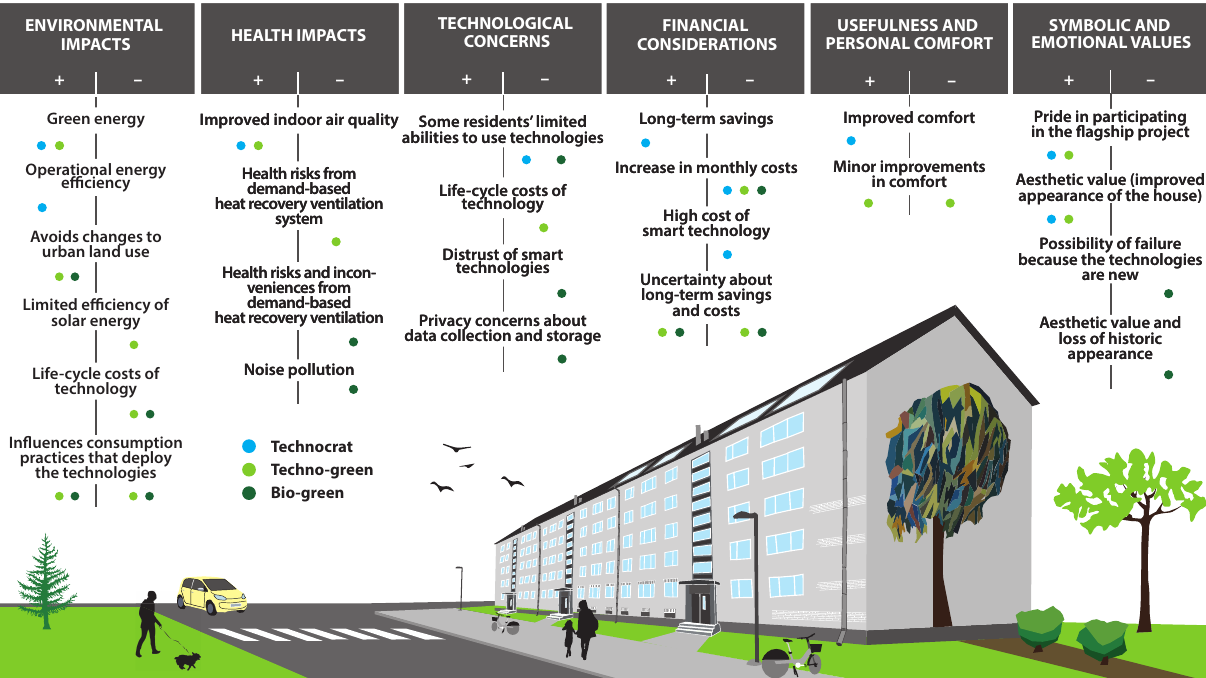
Figure 4. Meanings assigned to the smart retrofit intervention from respondents with different environmental and tech‐ nological dispositions. The symbol “ + ’’ indicates a positive attitude and “ − ’’ indicates a negative